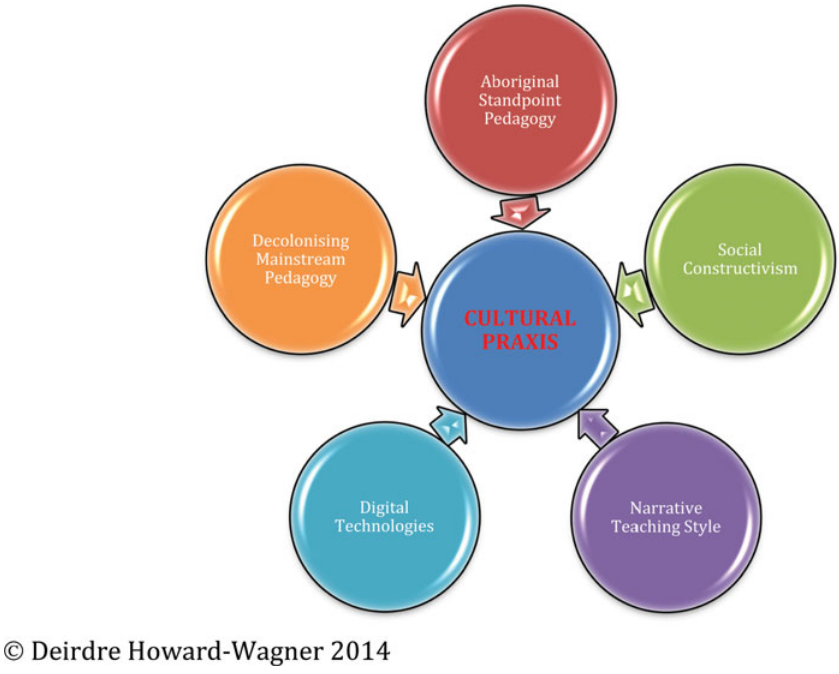
(Colour online) Online Kinship Project: Pedagogy as a Cultural Praxis